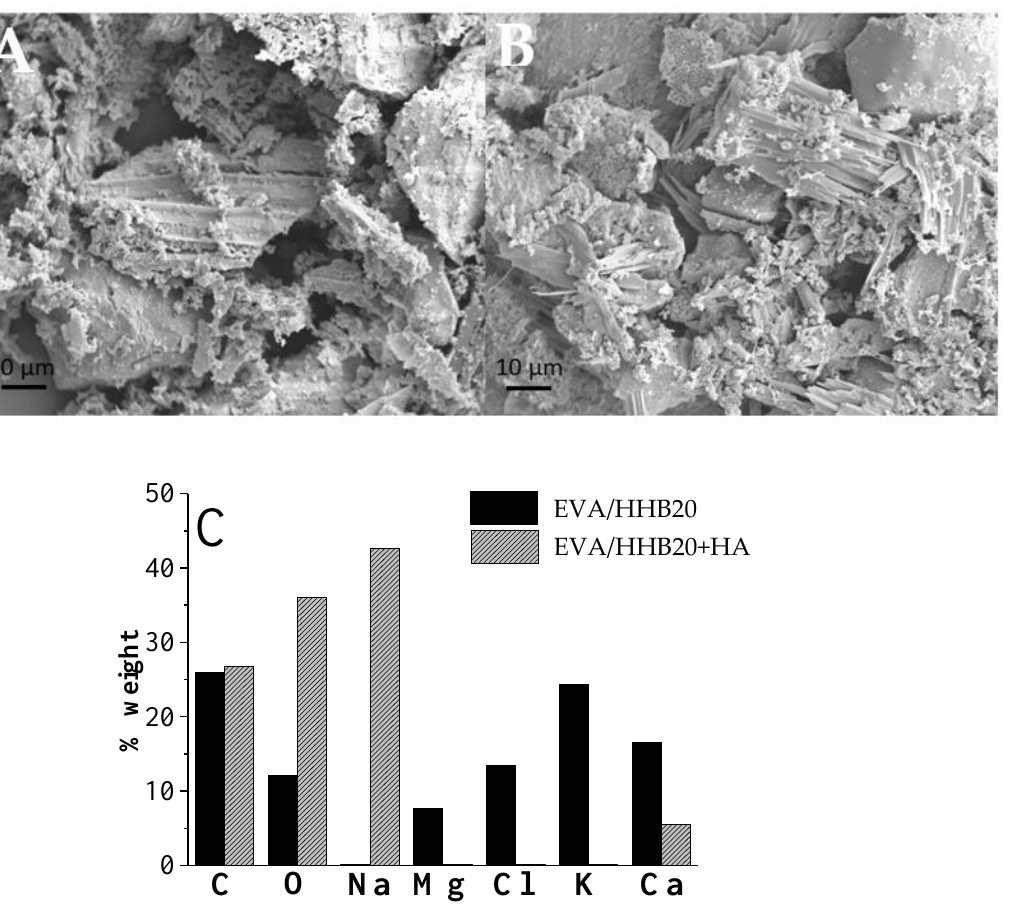
Figure 7. SEM micrographs of the residues after cone calorimetry tests for EVA/HHB20 ( A ), EVA/HHB20+HA ( B ), and their EDX analyses ( C ).